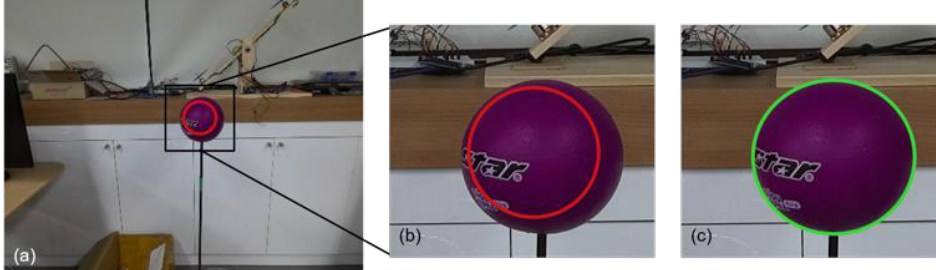
Figure 5. Sequence of the newly developed algorithm. ( a ) Original image captured by the MAV vision system; ( b ) cropped image using the HSV filtering result; ( c ) final spherical object detection using the detection algorithm. The red and green circles represent the detected result of the HSV filter and CHT, respectively.